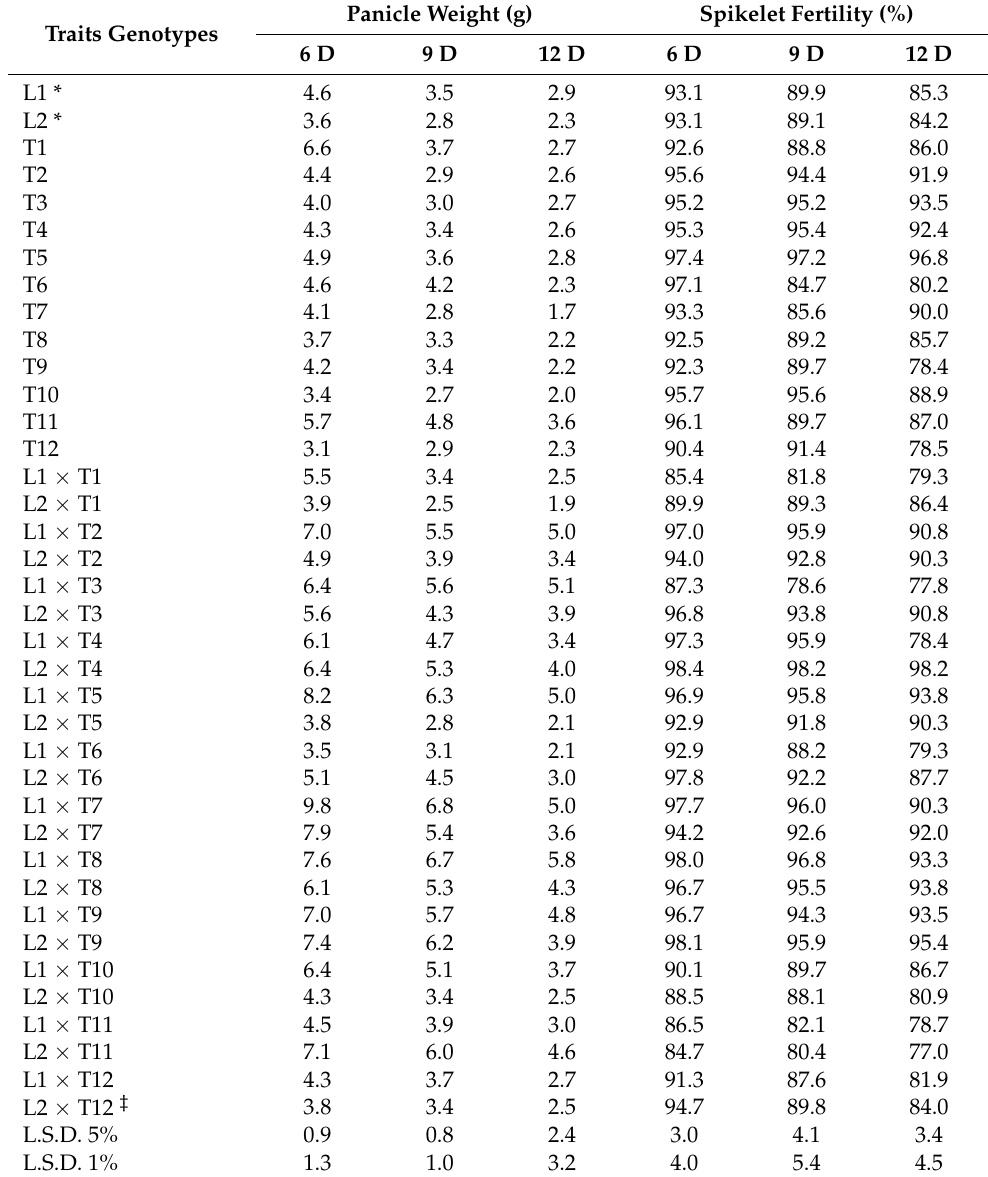
Table 4. Mean performances of grain yield and contributing traits for the studied genotypes. Traits